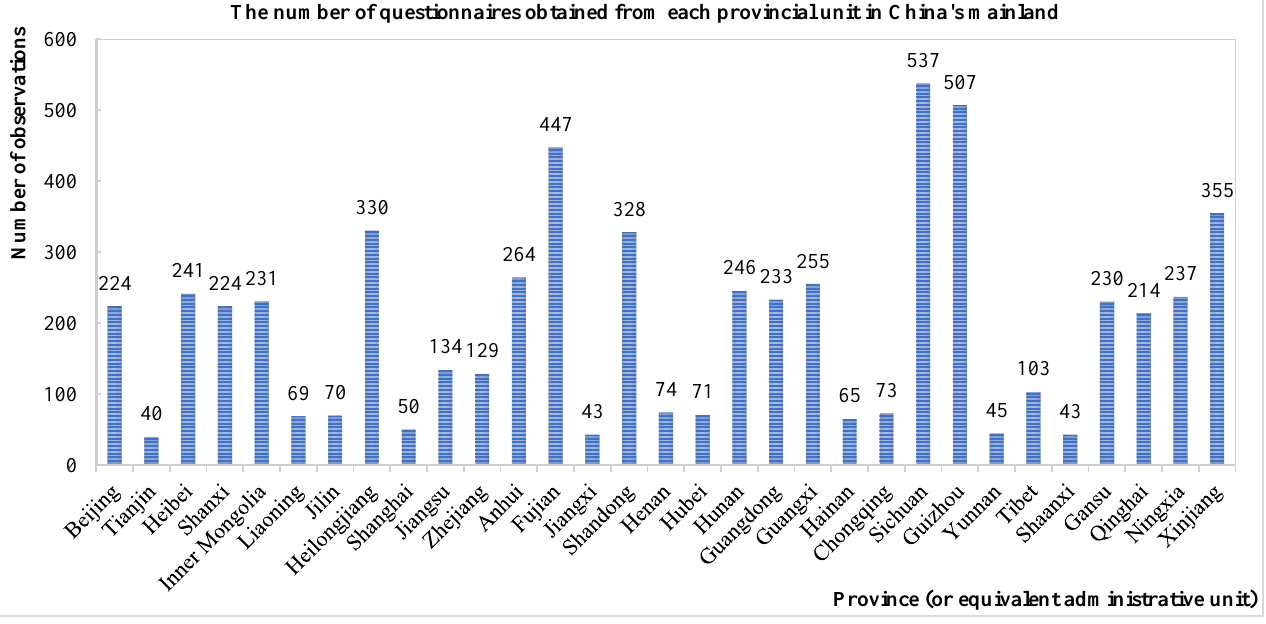
Figure 1. The number of questionnaires obtained in the surveys from each provincial-level unit of China ’s mainland 2